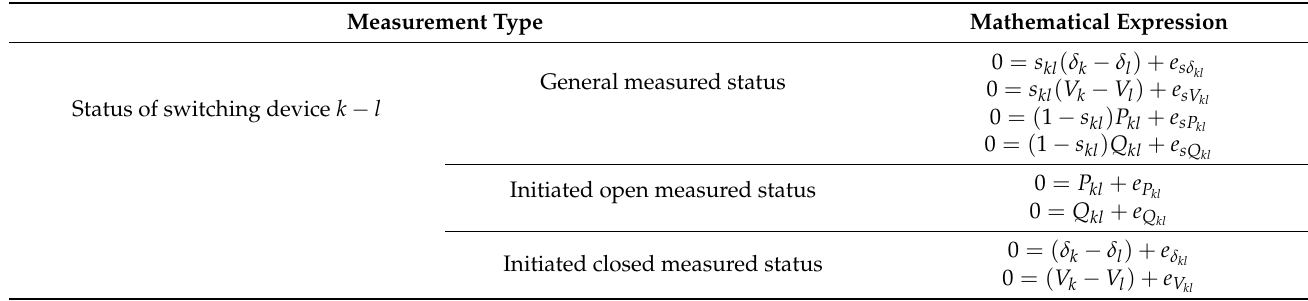
Table 2. Pseudo-measurements for the switching devices